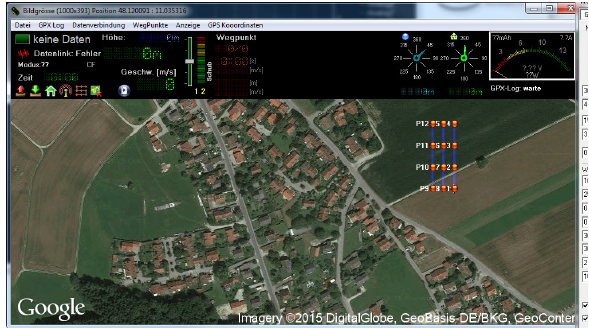
Figure 6: Mikrokopter OSD